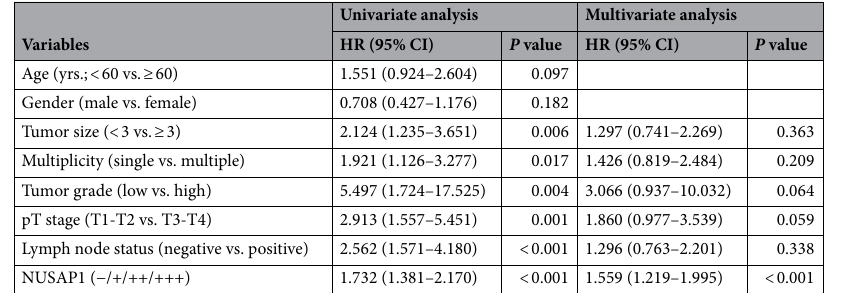
Table 6. Univariate Cox and multifactorial analysis for factors influencing 5-year-recurrence-free survival after surgery for BUC.